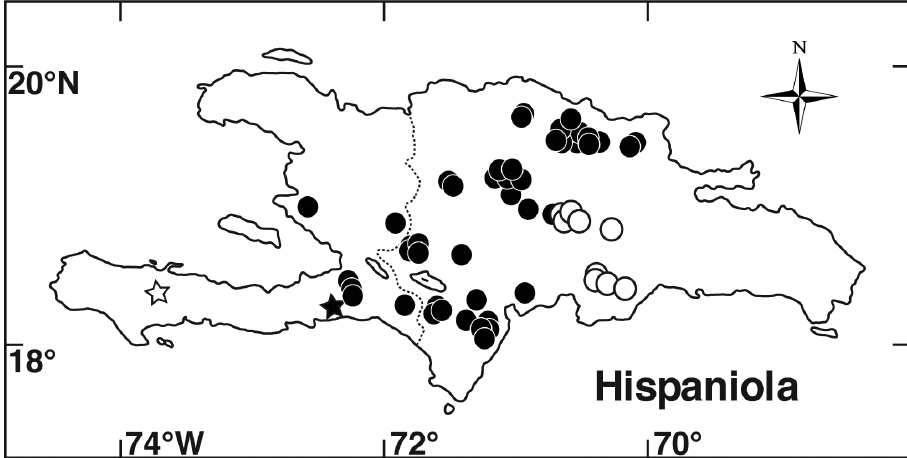
Figure 21. Distribution of Miconia marigotiana (closed star), M. lima (closed circles), M. pedunculata (open circles) and Miconia pagnolensis sp. nov. (open